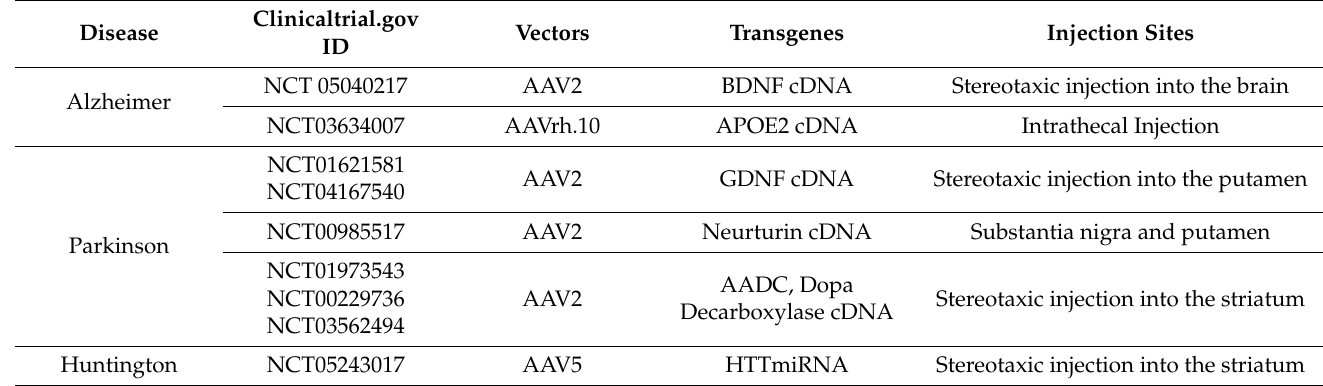
Strategies for AAV-mediated gene therapy of ND. Sample of clinical trials from clinicaltrial.gov for Alzheimer’s, Parkinson’s, and Huntington’s